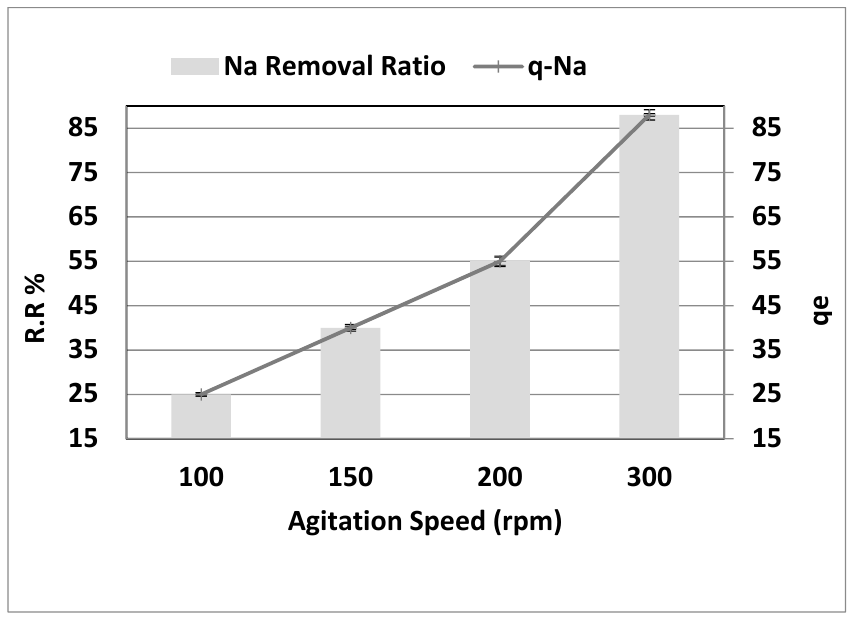
Figure 8. Effect of agitation speed on the removal efficiency and the adsorption capacity of NaCl, adsorbent dose = 10 g L − 1 , pH = 4, and contact time = 150 min.